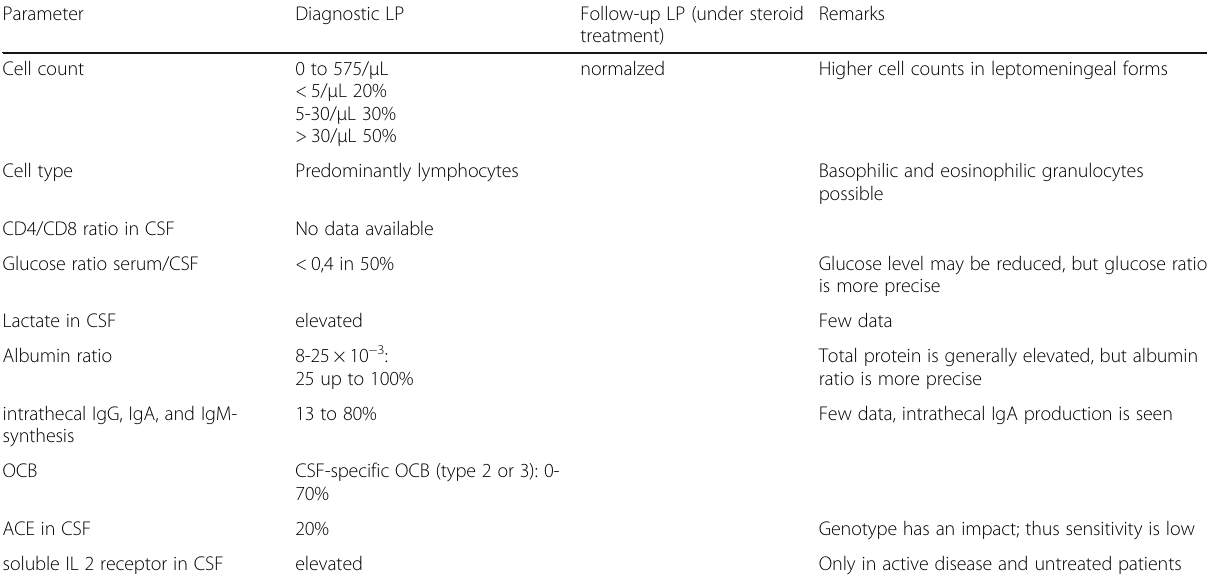
Table 14 CSF findings in patients with